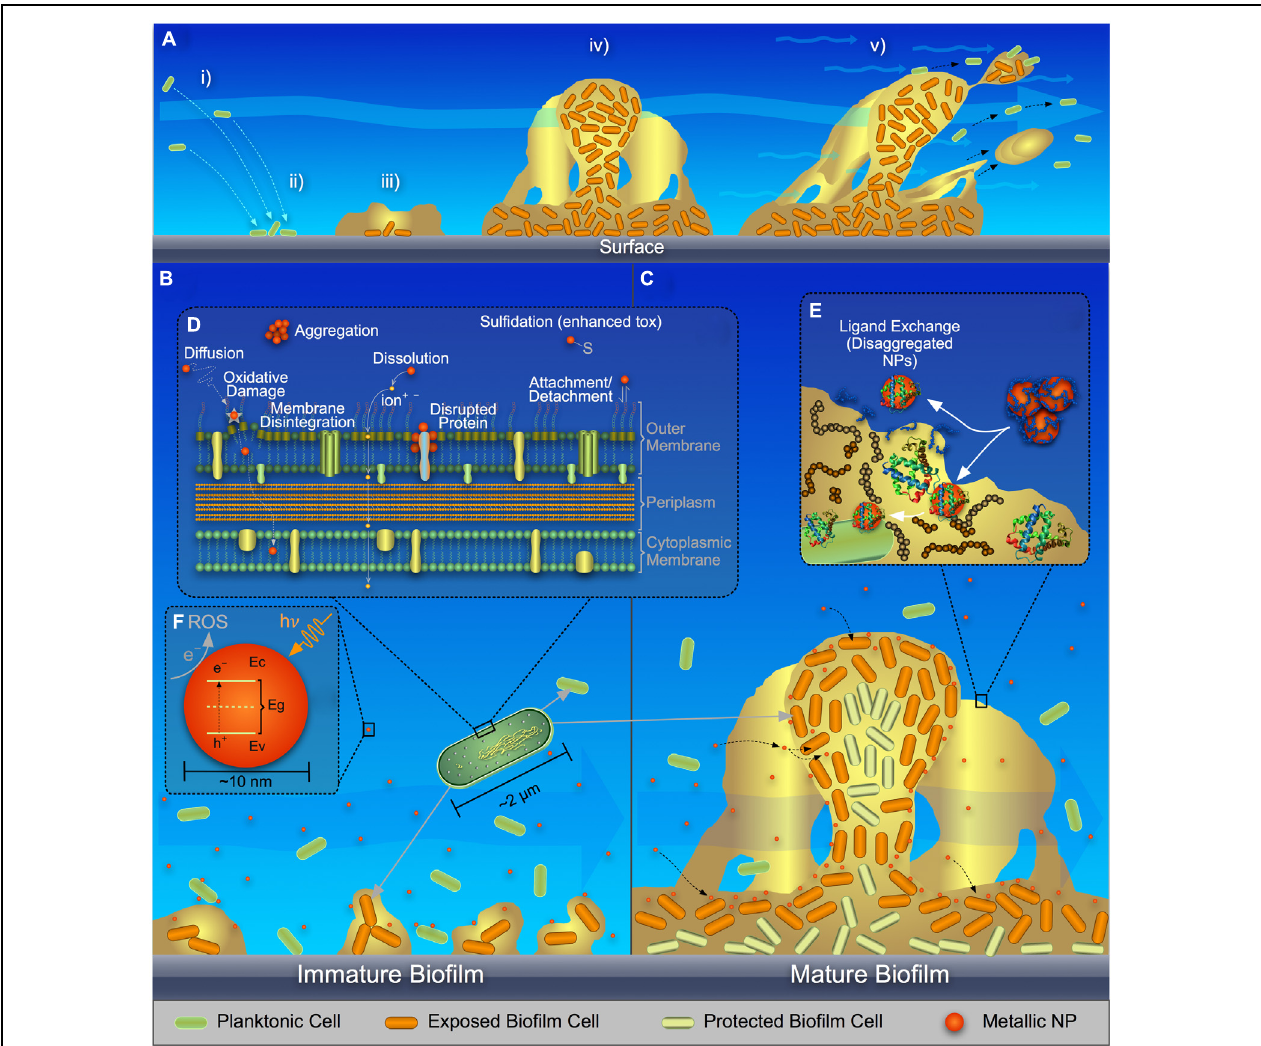
FIGURE 1 | Schematic representing (A) stages in biofilm formation and growth, (B) metal and metal-oxide nanoparticle (NP) interaction with planktonic bacteria and immature biofilm, (C) metal and metal-oxide NP interaction and translocation in mature biofilm, (D) a close-up of NP interaction with a cell surface, (E) ligand-exchange process of